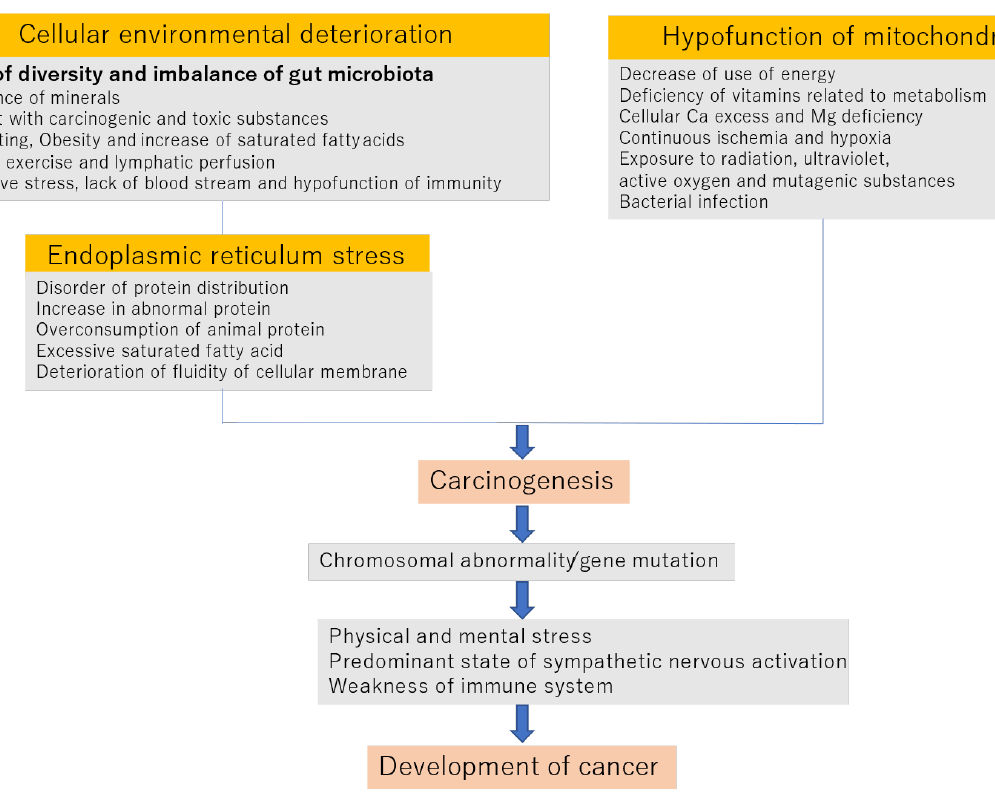
Figure 1. Mechanism of carcinogenesis and development of cancer.